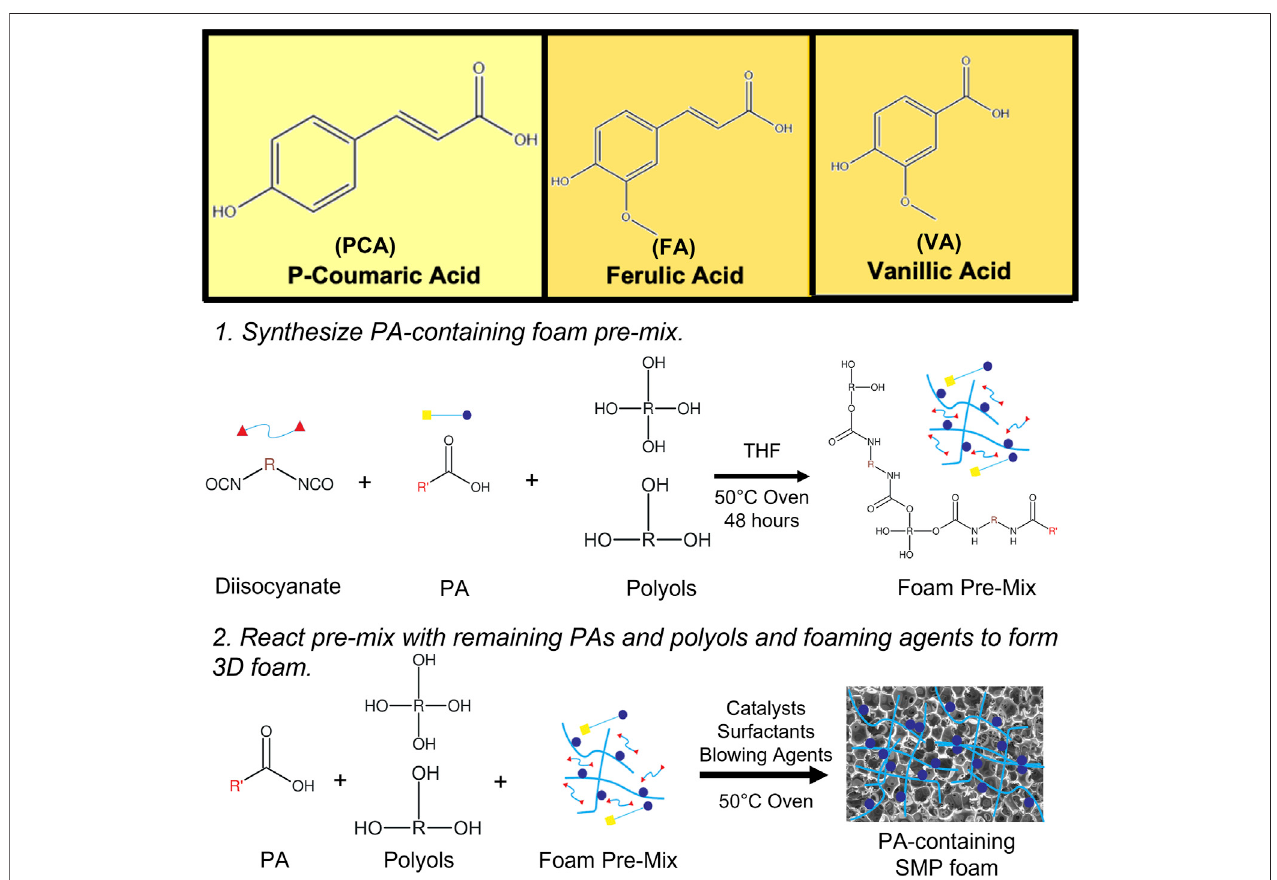
FIGURE 1 | Chemical structures of PCA, VA, and FA and schematic representation of PA incorporation into SMP foams.